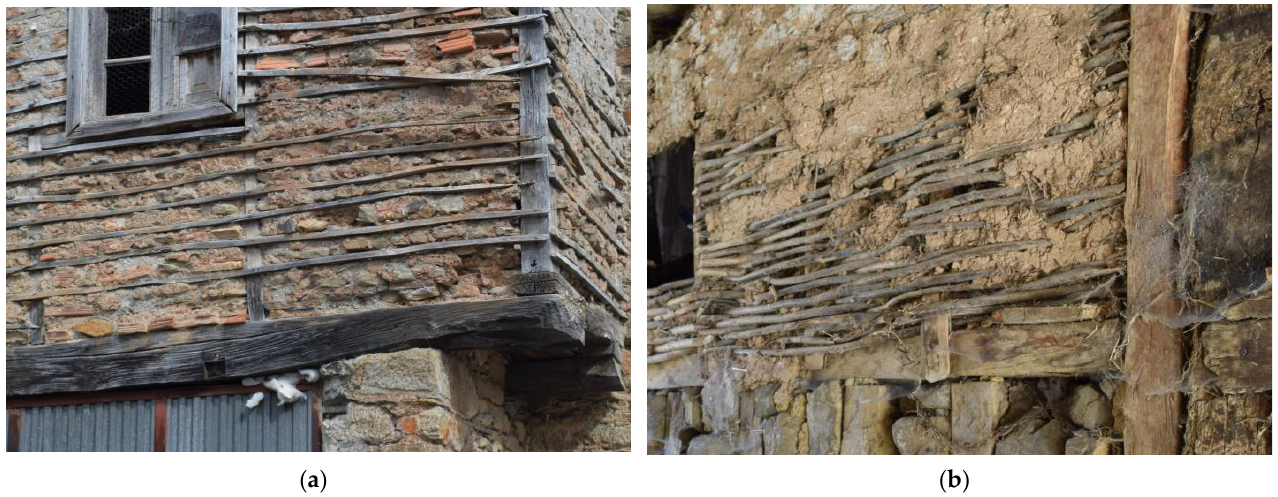
Figure 26. Half-timber walls with lightweight enclosures executed using wooden elements: ( a ) lath-and-daub enclosure with laths identified as Alnus glutinosa L. in Almagarinos (León); ( b ) Wattle-and-daub enclosure with flexible rods identified as Corylus avellana L. in Caloca (Cantabria).